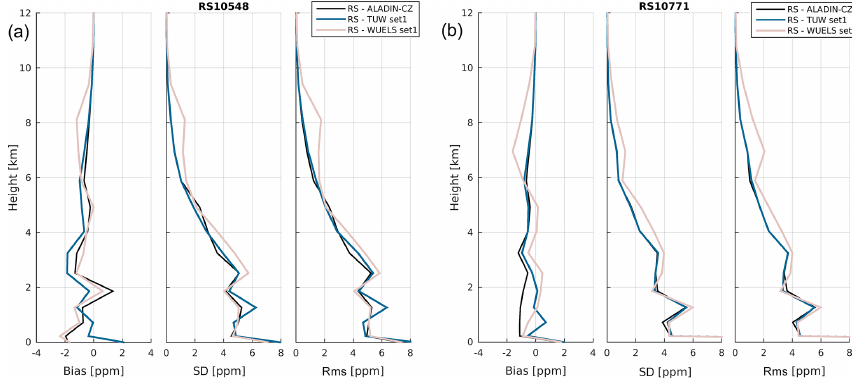
Figure 9. Statistics of the differences in wet refractivity at radiosonde sites RS10548 (a) and RS10771 (b) .